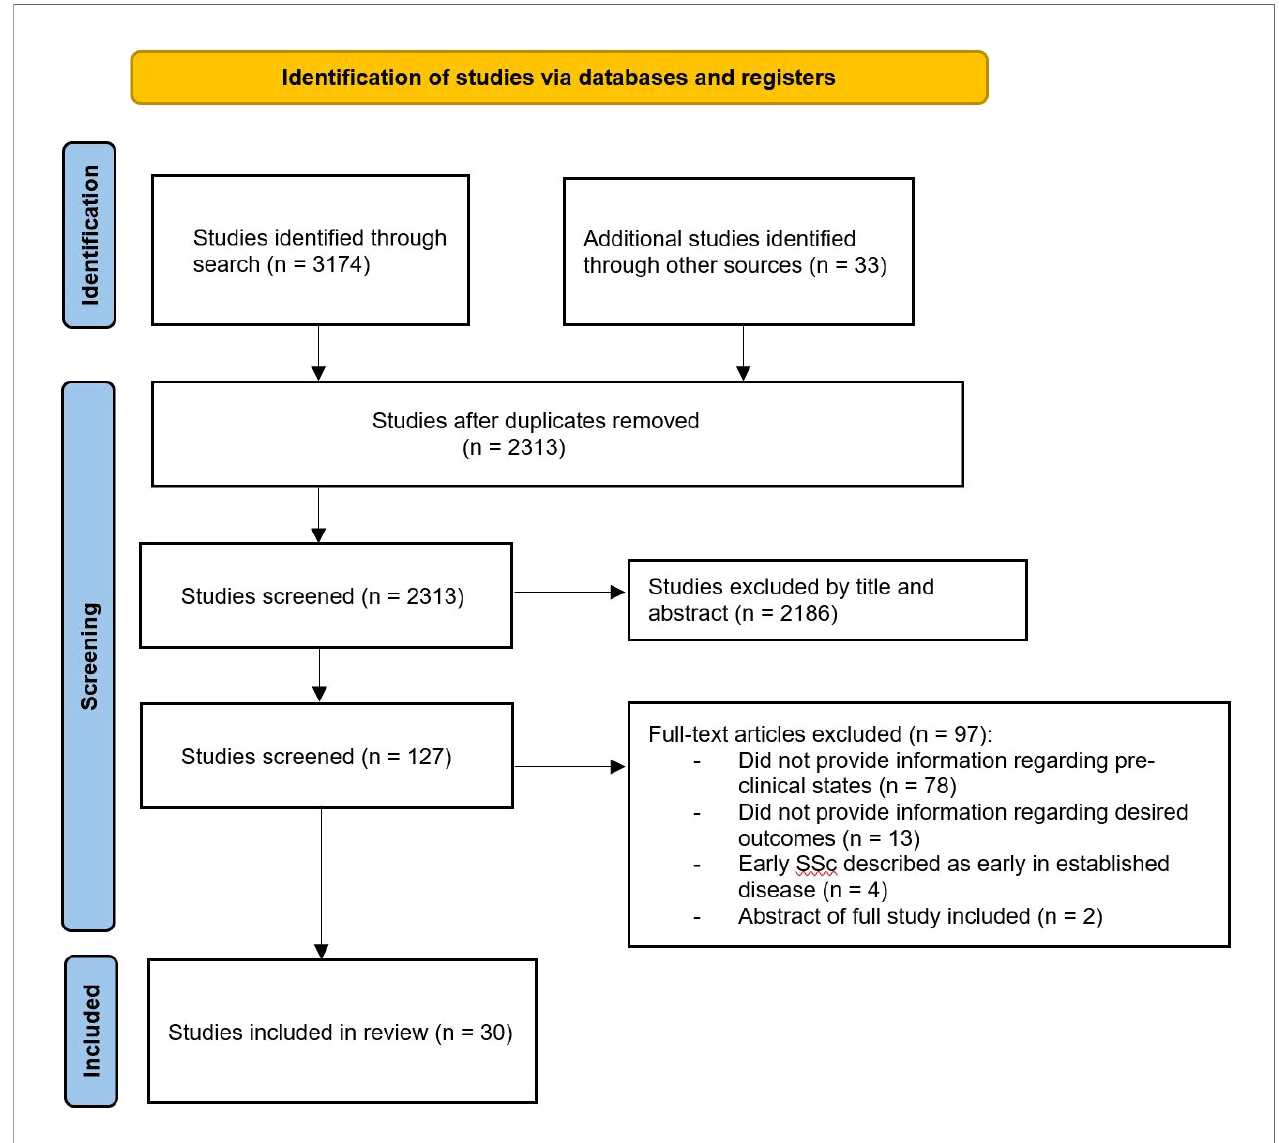
FIGURE 1 | Flow diagram of scoping review selection